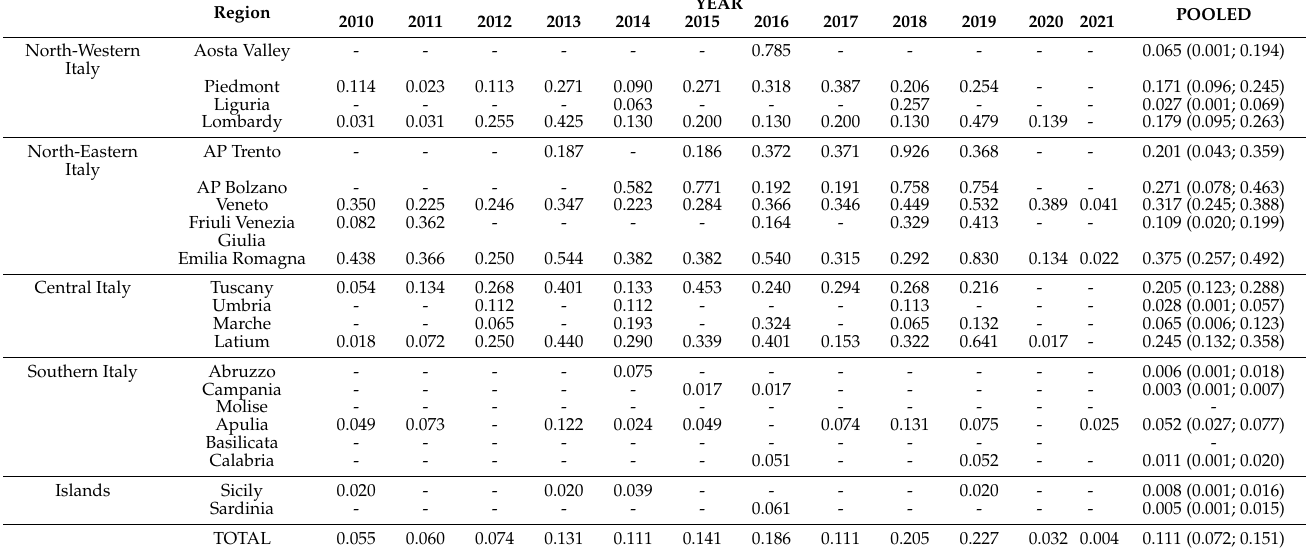
Table A1. Cases of Dengue fever reported in Italy between 2010 and